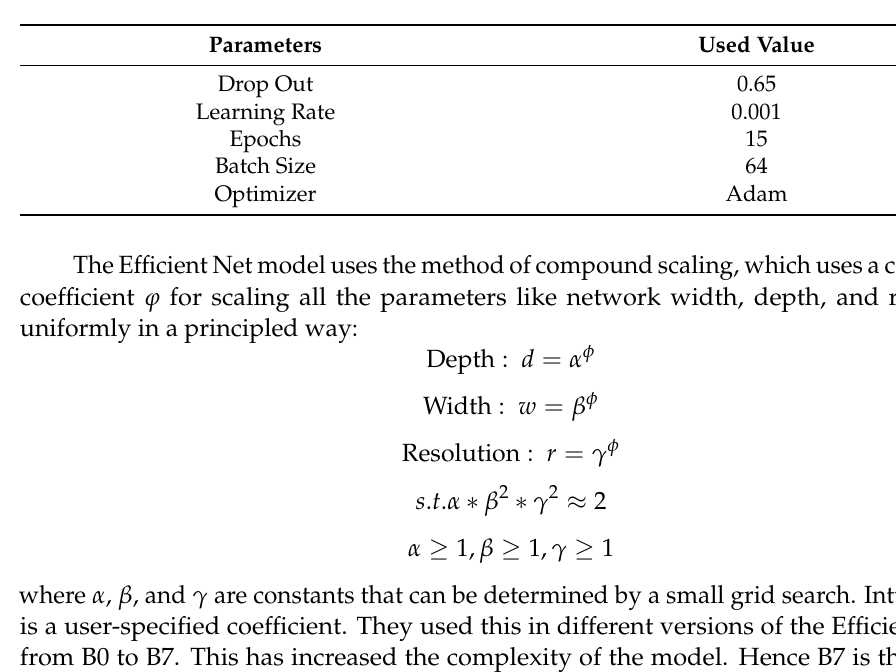
Table 1. Parameters used in the Efficient Net model.